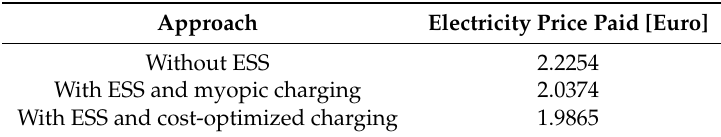
Table 4. Price comparison between different approaches for Scenario